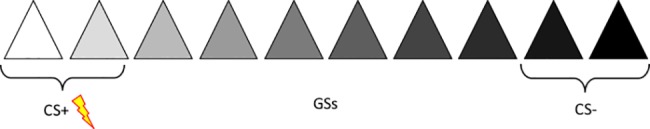
Stimulus set two.